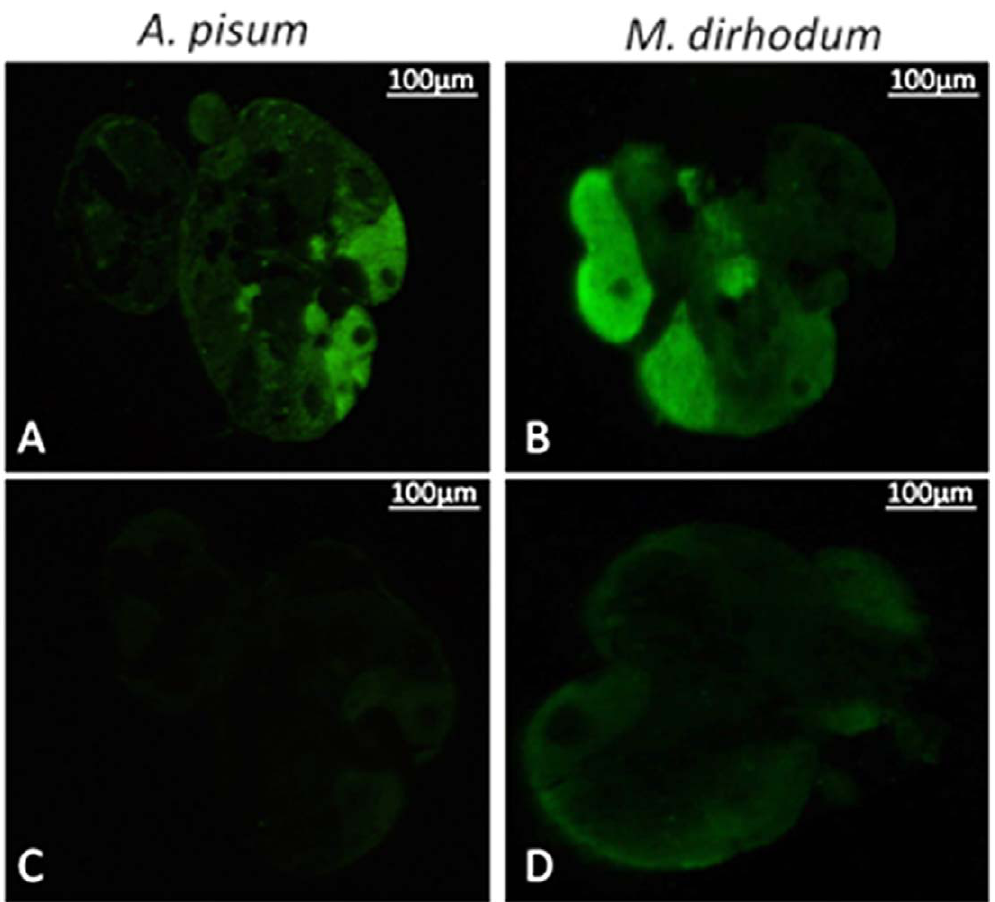
Figure 5. Immunolocalisation of ACYPI009881 within a single principal salivary gland from A.pisum and M.dirhodum . Tissue sections were incubated with either anti-ACYPI009881 antibody (A, B) or anti-ACYPI009881 antibody blocked with immunizing peptides (C, D). Scale bar in all figures represents 100 m m.